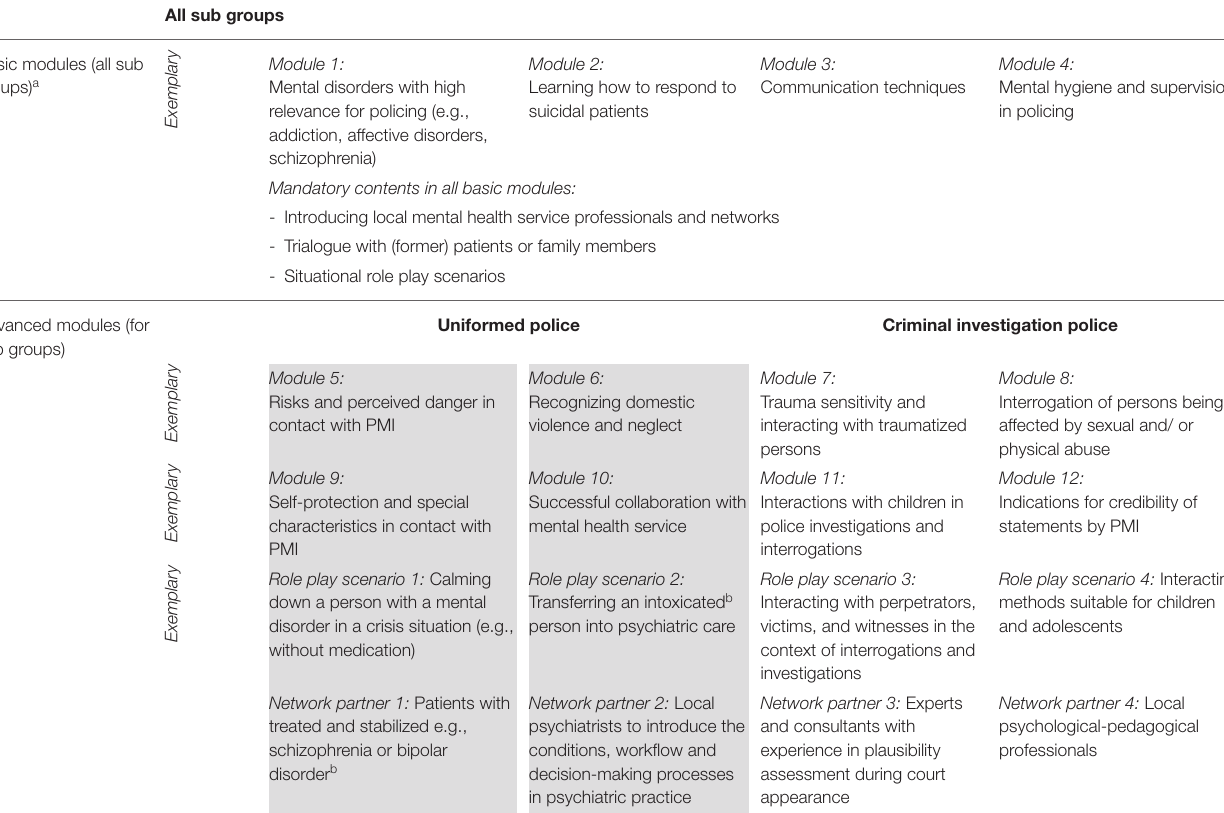
TABLE 3 | Exemplary training program. All sub